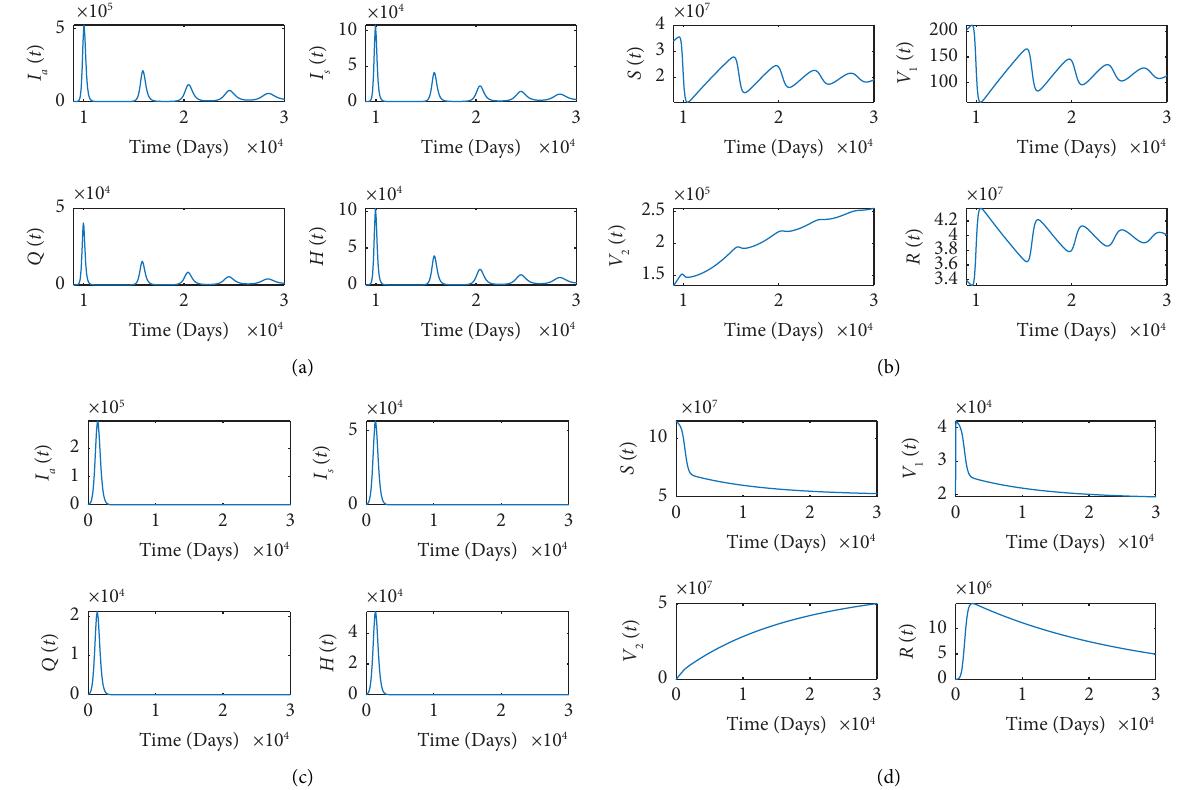
Figure 5: Local stability of the endemic equilibrium for R local stability of the disease free equilibrium for R v � 0 . 556 < 1 (infected compartments (c), and noninfected compartments (d)) τ p � 5 × 10 − 5 is used for panels ( a ) and ( b ) and ( c ) and ( d ) , respectively, and other parameter values are given in Table 2. 1